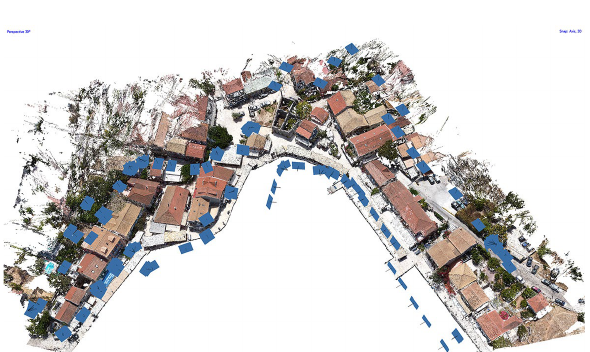
Figure 10 . Fiskardo Port, dense cloud of dots.